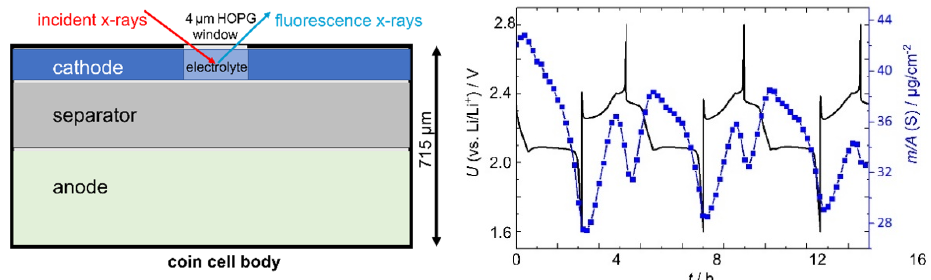
Figure 8. Set-up of a 715 µm thick coin cell battery probing S-K-related XRF and XAFS signals through a 4 µm thick HOPG entrance window under operation conditions ( left ). The elemental mass deposition m / A of sulfur (S) in dissolved PS is depicted in blue for the cathode side for the first three full cycles ( right ), while the electrochemical performance is depicted in black, corresponding to a percentage of lost cathodic sulfur ranging from about 15% to 25%.